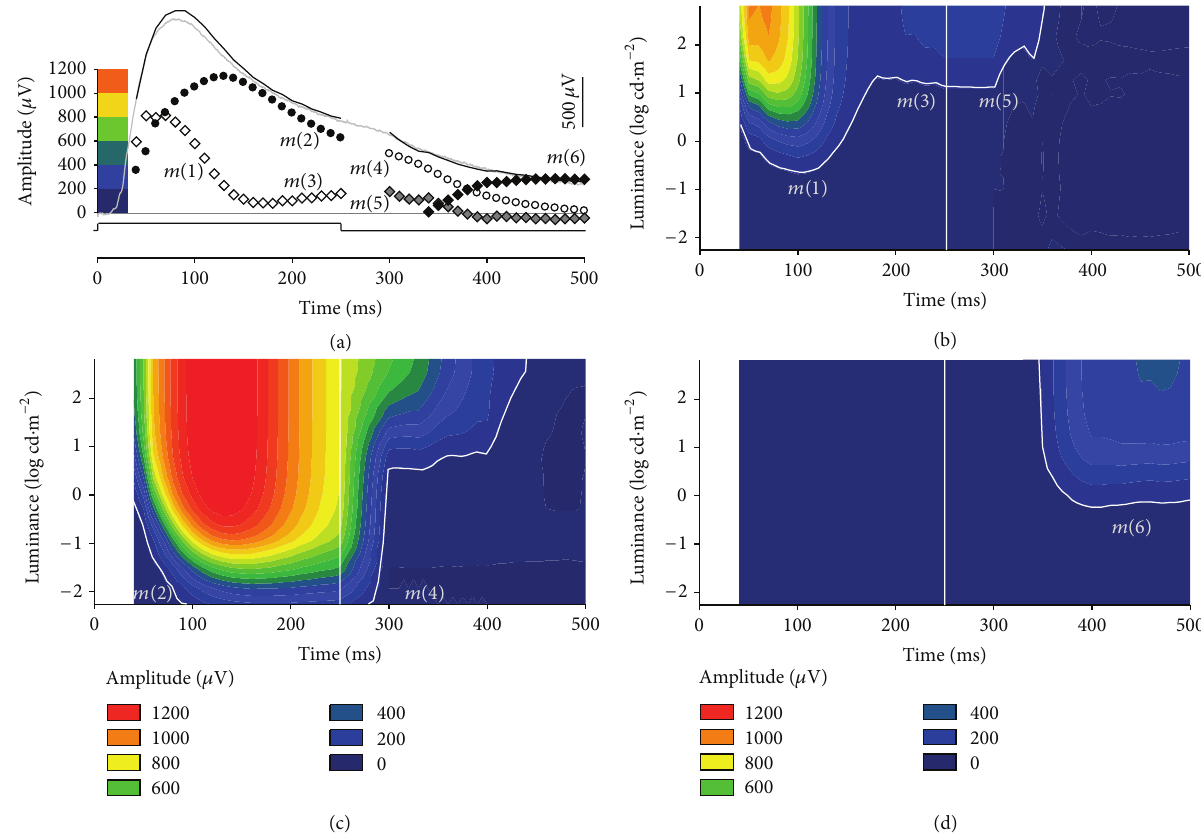
Figure 8: Summary of components underlying the rat PII response to a light step. (a) The interactions between the various components derived from our modeling are shown for the brightest luminance. Hence, there appear to be a minimum of three components underlying the scotopic ERG PII elicited using a light step. ( 𝑚 ( 1 ) and 𝑚 ( 3 ): unfilled diamonds, 𝑚 ( 2 ): black circles, 𝑚 ( 4 ): unfilled circles, 𝑚 ( 5 ): grey diamonds, and 𝑚 ( 6 ): black diamonds). (b)–(d) show individual components plotted on a contour plot, as a function of time and luminance, with larger amplitudes indicated by warmer colors. (b) 𝑚 ( 1 ) has fast rise and decay characteristics with a low sensitivity to light. With longer times 𝑚 ( 1 ) transitions to m ( 3 ). After stimulus offset, m ( 3 ) continues as m ( 5 ) and relaxes back to baseline. (c) m ( 2 ) has slow rise and decay characteristics and is more sensitive to light. After stimulus offset, m ( 2 ) continues as 𝑚 ( 4 ) and relaxes back to baseline. (d) A long latency small amplitude sustained positive component m ( 6 ) occurs after stimulus offset at higher